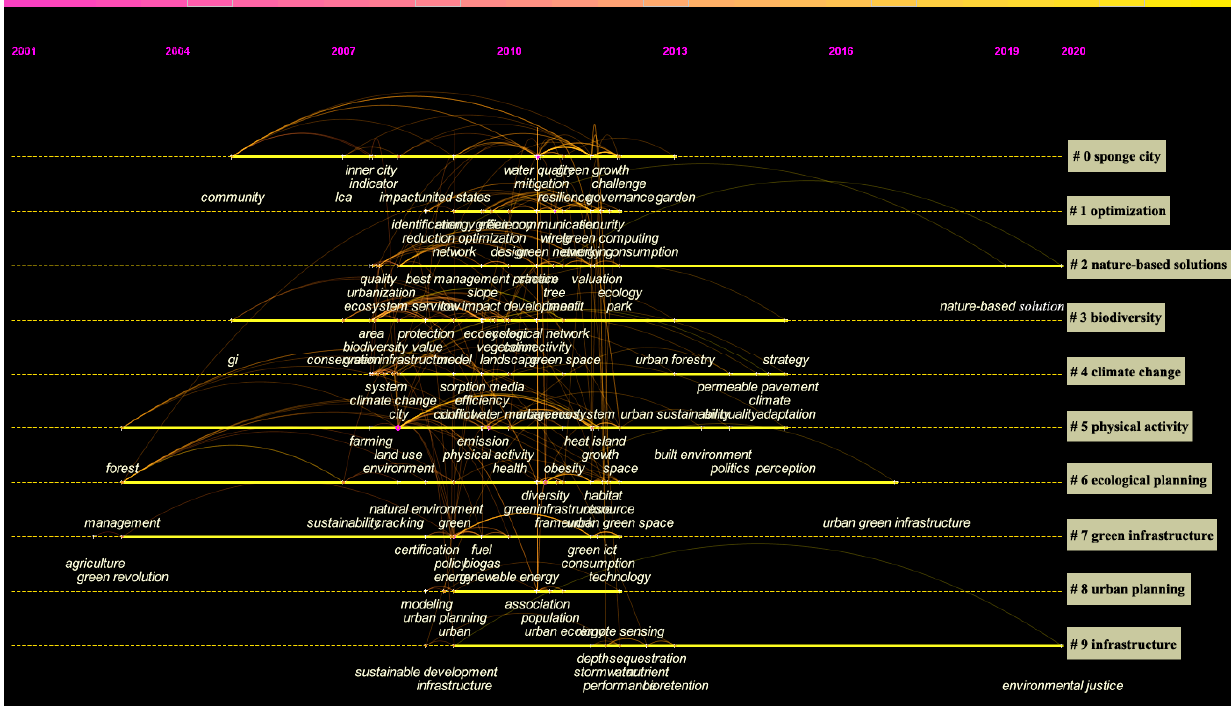
Figure 5. Keyword timeline in the literature on green infrastructure from Web of Science (WOS).